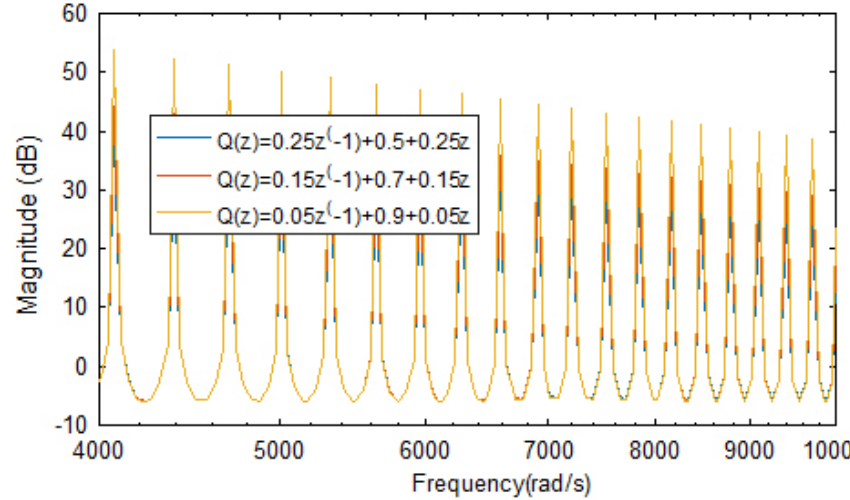
Figure 12. Frequency characteristics of ILC with low pass filter